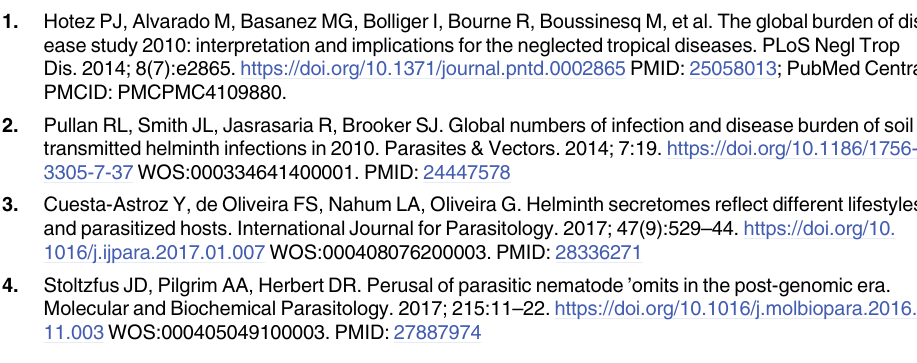
S6 Table. 183 S. carpocapsae venom orthologs to S. feltiae . List of 183 S . carpocapsae (L596)